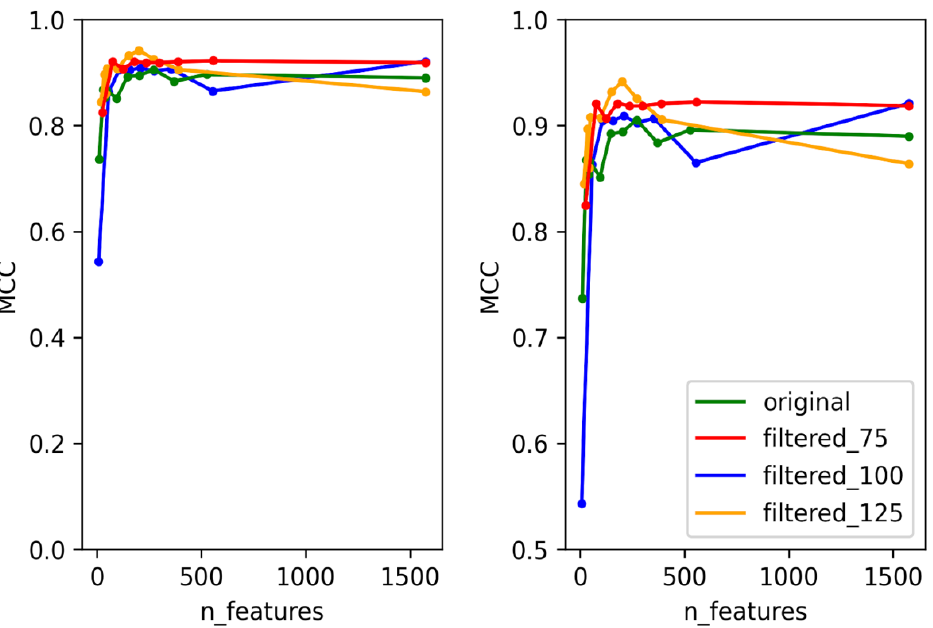
Figure 5. Test MCC of ParA predictor using original dataset and filtered datasets using different numbers of features.